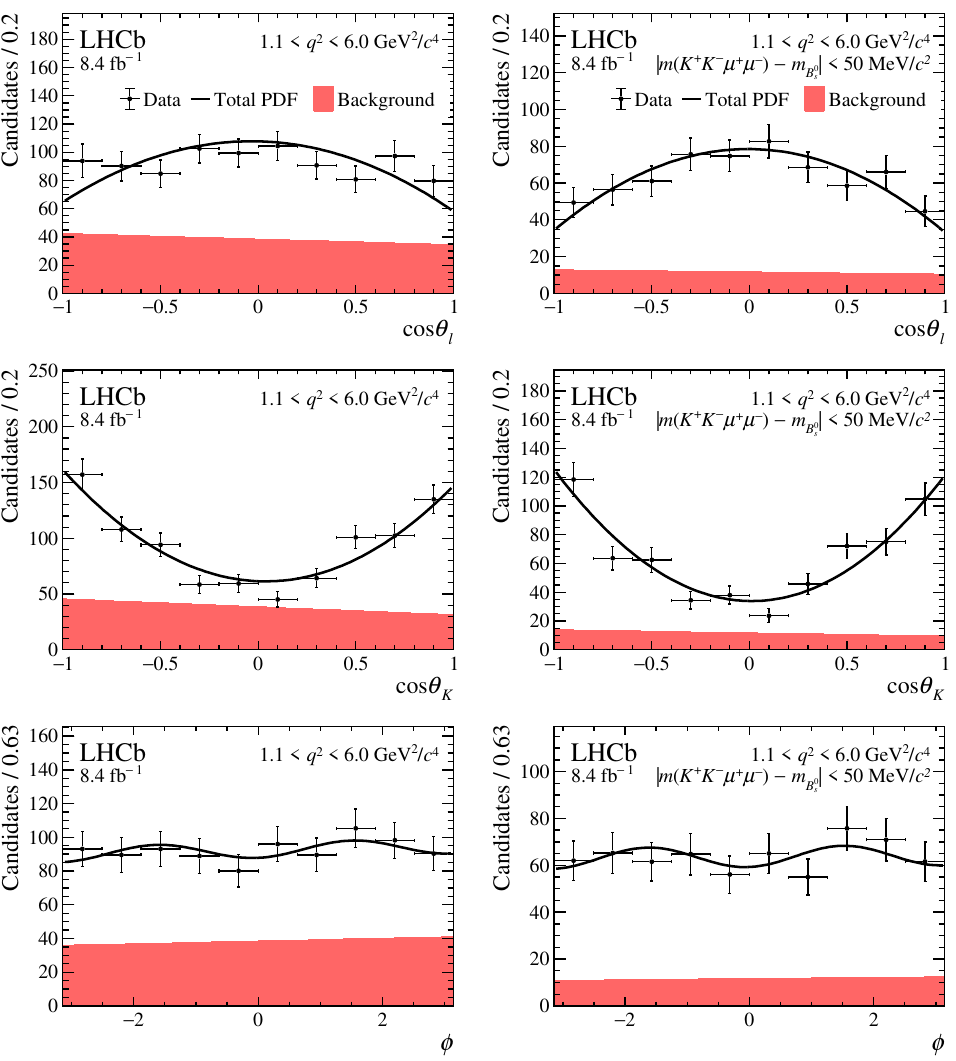
Figure 2 . Angular projections in the region 1 . 1 < q 2 < 6 . 0 GeV 2 /c 4 for the combined 2011–2012, 2016 and 2017–2018 data sets. The data are overlaid with the projection of the combined PDF. The red shaded area indicates the background component and the solid black line the total PDF. The angular projections are given for candidates in (left) the entire mass region used to determine the observables in this paper and (right) the signal mass window ± 50 MeV/ c 2 around the known B 0 s